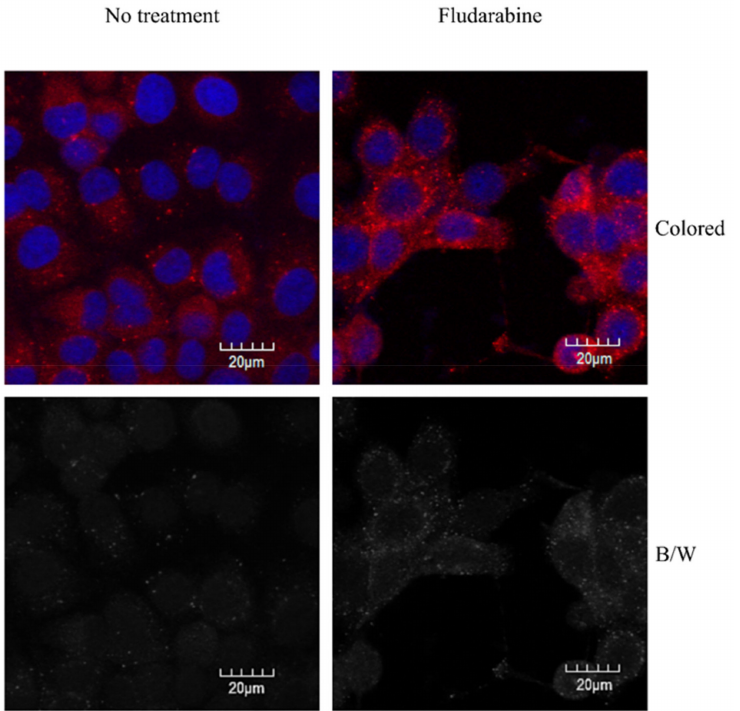
Figure 3. Confocal immunofluorescent photomicrographs taken from confocal microscopy of LLC- MK2 cells after 24 h of treatment with Fdb (5.0 µ M). The treated cells were briefly fixed in absolute methanol at − 20 ◦ C, permeabilized with 0.1% Triton X-100, and then immunohistochemically stained with autophagy-activated protein (LC3B-I/LC3B-II) antibody and secondary antibody-conjugated Alexa ® 555. The fluorescent illumination of LC3B-II foci (autophagosome) was demonstrated in the cytoplasm of the cells. LC3B Alexa ® -stained = red, DAPI nuclear-stained =